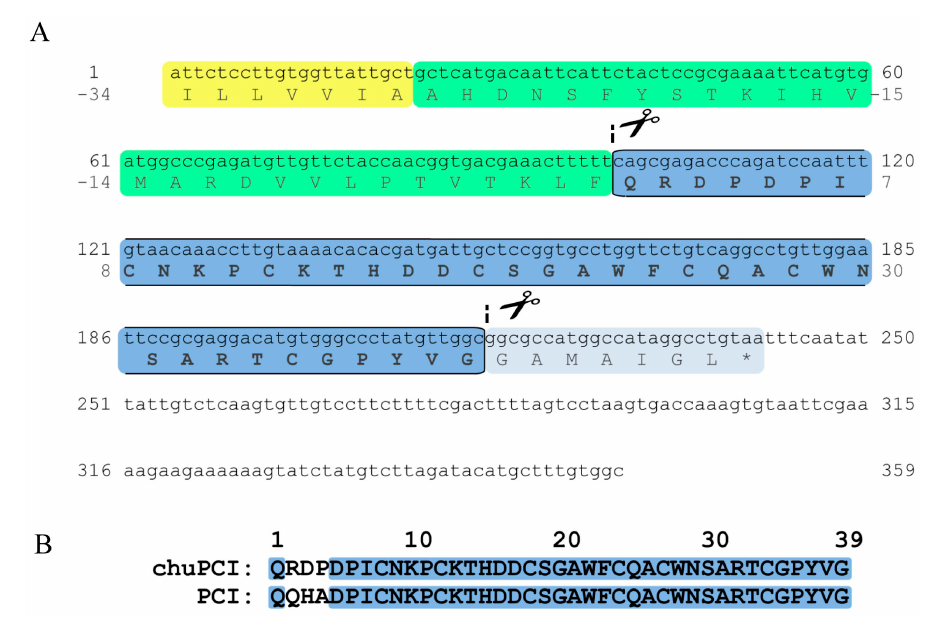
Figure 3. Nucleotide and deduced amino acid sequences of the chuPCI precursor. ( A ) cDNA of chuPCI was isolated from the RNA of tuber buds from S. tuberosum subsp. andigenum cv. Churqueña, a variety of Andean potato. The organization of the primary structure is indicated: residues belonging to the signal peptide (sequences highlighted in yellow); N-terminal pro-segment of the inhibitor (sequences highlighted in green); mature chuPCI (sequences highlighted in blue and boxed); C-terminal extension (sequences highlighted in grey). Scissors indicates the specific post-translational cleavage sites required to obtain the mature chuPCI molecule; ( B ) Sequence alignment of the deduced amino acid sequences of mature chuPCI and the sequence of canonical PCI ( S. tuberosum , subsp. tuberosum , GenPept: NP_001275048.1). Conserved amino acids are highlighted in blue, while non-conserved residues are shown unmarked.